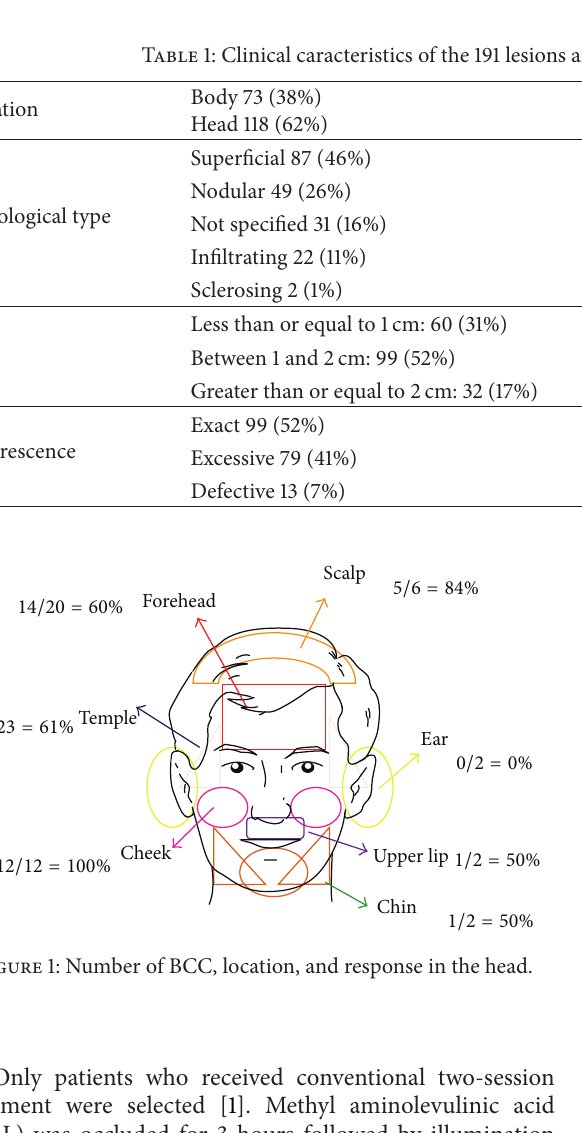
Only patients who received conventional two-session treatment were selected [1]. Methyl aminolevulinic acid (MAL) was occluded for 3 hours followed by illumination with red 630 nm light at 37 J/cm 2 for 7 minutes (Aktilite). The BCC lesions were only subjected to cleaning with gauze and saline solution prior to application of MAL and nBCC lesions also underwent light and superficial curettage as defined in treatment guidelines